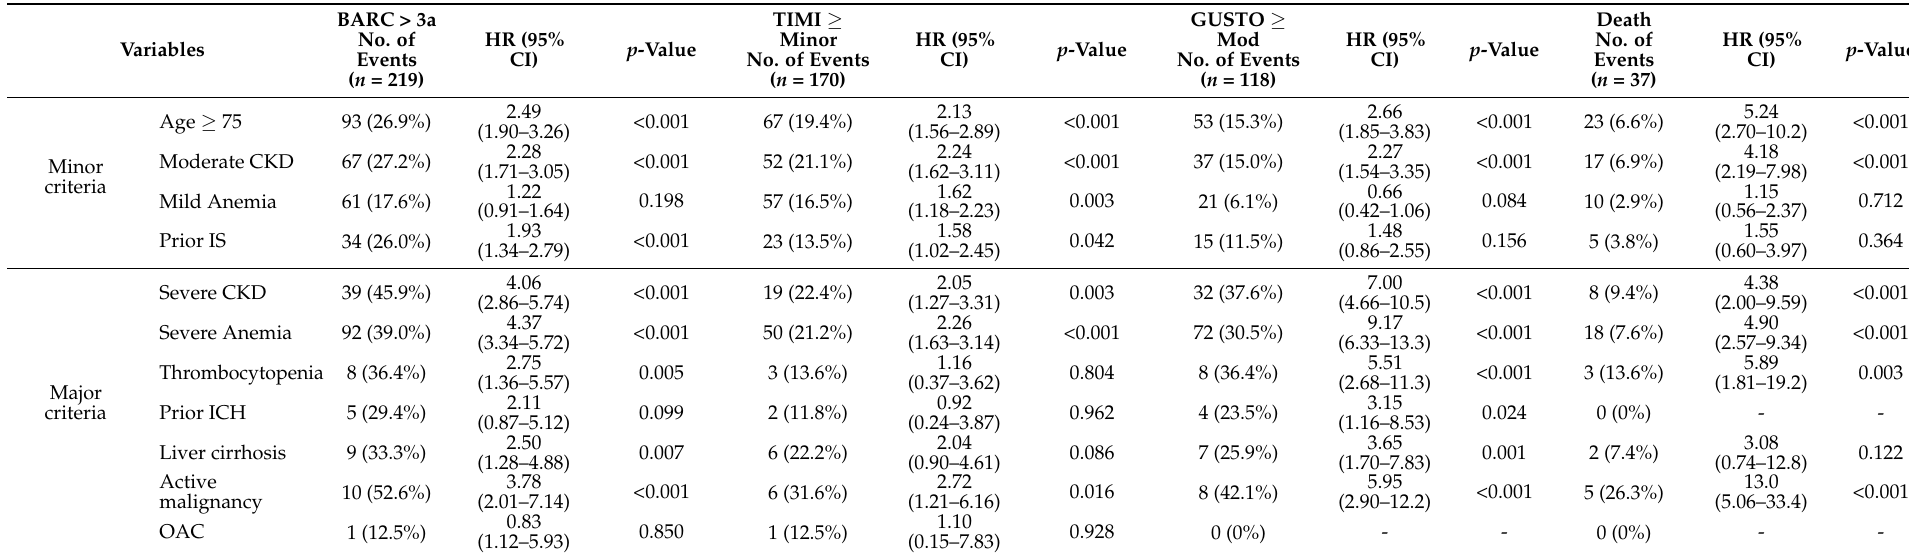
Table 3. Risk of clinical events according to Academic Research Consortium for High Bleeding Risk (ARC-HBR)